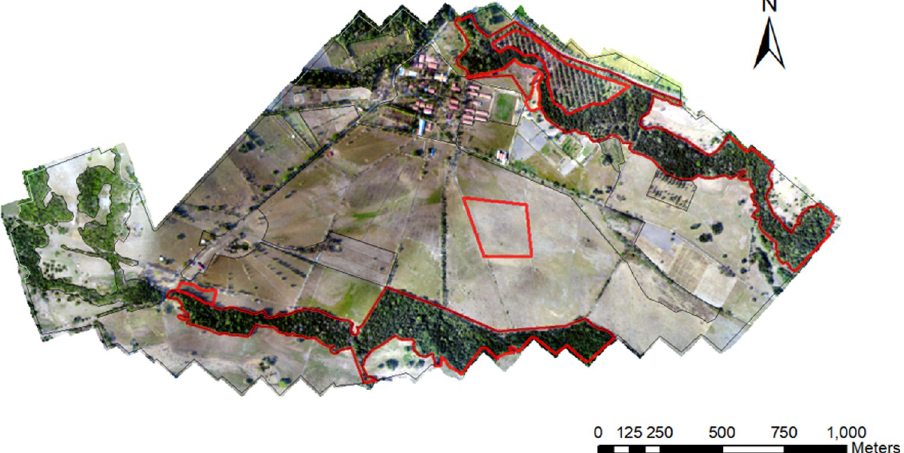
Fig 1. Aerial view of the Matepantano farm study area from the orthomosaic taken by a dron imaging service. Red lines encircle areas of the potential habitats to select the sample sites.